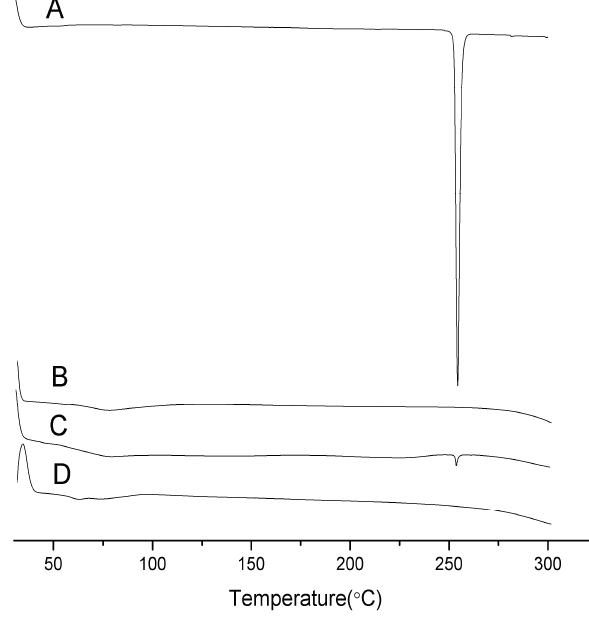
Figure 2. DSC curves of Aprepitant ( A ); Soluplus ® ( B ); 1:5 pysical mixtures ( C ); and SDs ( D ).